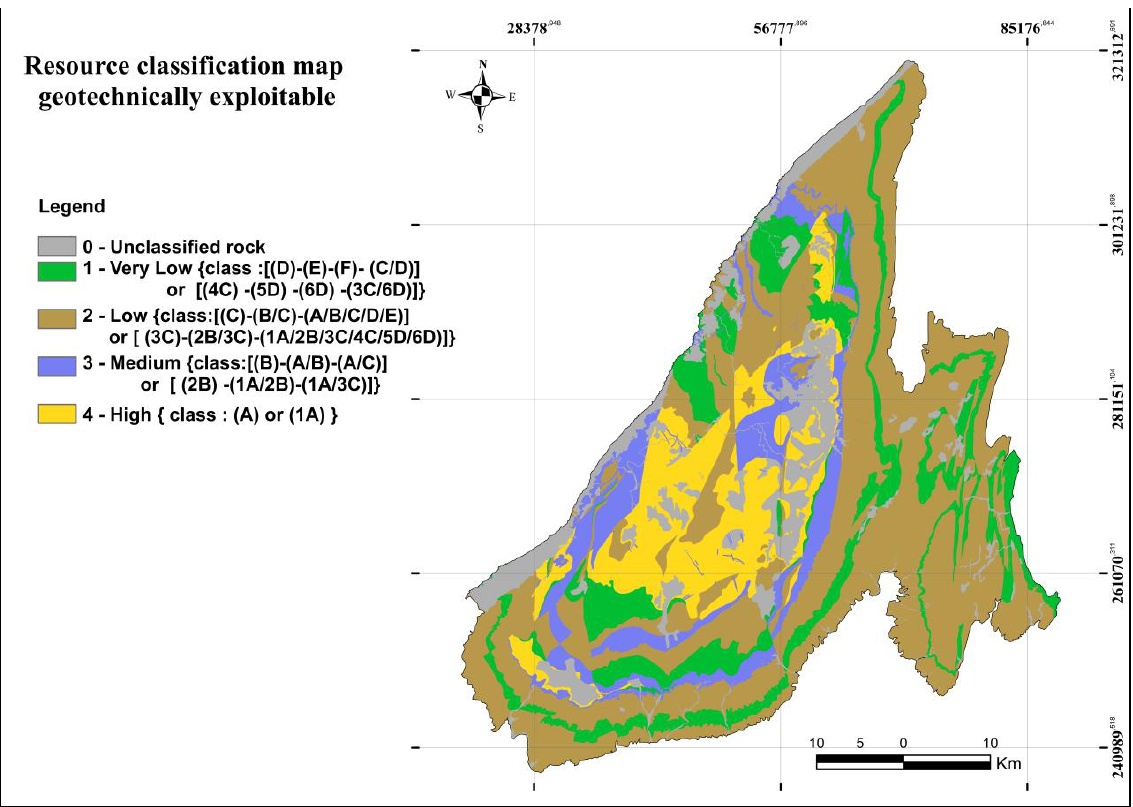
Figure 7. Geotechnical Resource Classification Map.